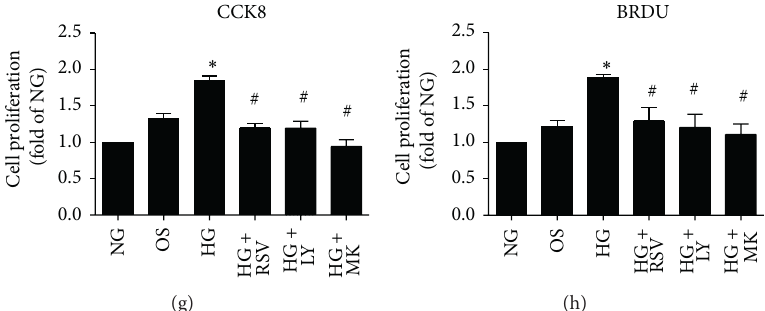
Figure2:Resveratrol(RSV)attenuatedhighglucose-(HG-)inducedplasminogenactivatorinhibitor(PAI-1)expressionandcellproliferation in rat mesangial cell (RMC), which might be Akt/nuclear factor-kappa B (NF- 𝜅 B) pathway dependent. RMCs were cultured in DMEM containing 5.6 mM glucose (NG) and 10% FBS. When the confluence reached at 60%–70%, the medium was replaced with NG and 0.2% BSA. 24 h later, the cells were pretreated with 10 𝜇 M LY294002, 1 𝜇 M MK-2206, or an equal volume of DMSO for 30 min and then incubated for another 24 h with or without HG (25 mM) in the presence or absence of RSV (25 𝜇 M). After that, cells were collected and protein levels of PAI-1 ((a), (b)), Akt, p-Akt ((c), (d)), and NF- 𝜅 B ((e), (f)) were detected using Western blotting assay. Additionally, cell proliferation was examined with CCK8 assay and BrdU incorporation, respectively. Results represent as mean ± SD. ∗ 𝑃 < 0.05 compared with NG, # 𝑃 < 0.05 compared with HG.